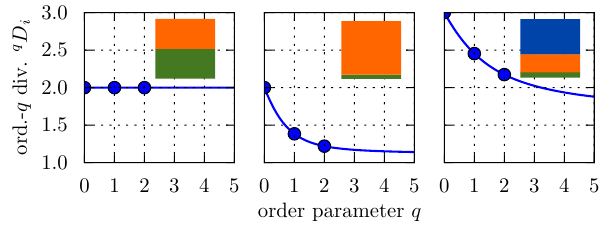
Fig. 10. Generalized per-particle diversity q D i of order q for vary- Fig. 4: Generalized per-particle diversity q D i of order q for ing q , shown for three different particles (inset square plots). Left: varying q , shown for three different particles (inset square a particle with equal amounts of two species. Center: a particle with plots). Left: a particle with equal amounts of two species. two species in unequal amounts. Right: a particle with three species Center: a particle with two species in unequal amounts. in unequal amounts. The order q controls the importance of species Right: a particle with three species in unequal amounts. The with small mass fraction. When q = 0 all species are taken to be order q controls the importance of species with small mass equally present, irrespective of mass fraction, so 0 D i is simply the fraction. When q = 0 all species are taken to be equally number of species present in the particle. When q = 1 the gener- present, irrespective of mass fraction, so 0 D i is simply the alized diversity is equal to the regular diversity defined from the number of species present in the particle. When q = 1 the Shannon entropy in Sect. 2. When q = 2 the generalized diversity P A 2 D generalized diversity is equal to the regular diversity defined (p a ) 2 for parti- i is the inverse of the Simpson index λ i = a = 1 i from the Shannon entropy in Section 2. When q = 2 the gen- cle i (Simpson, 1949), often used in the form of the Gini-Simpson eralized diversity 2 D i is the inverse of the Simpson index index 1 − λ i (Peet, 1974; Jost, A  i = ( p a ) 2 for particle i (Simpson, 1949), often used i a =1  i (Peet, 1974; in the form of the Gini-Simpson index 1  P Jost, 2006).